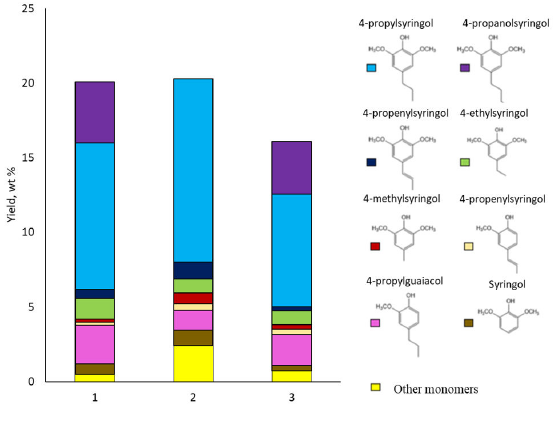
Figure 4. Influence of the time of the acid treatment of birch wood on the content of phenolic com- pounds in the liquid products of Ru/C catalyzed hydrogenation of initial (1), 2.5 h acid-pretreated (2) and 5 h acid-pretreated (3)